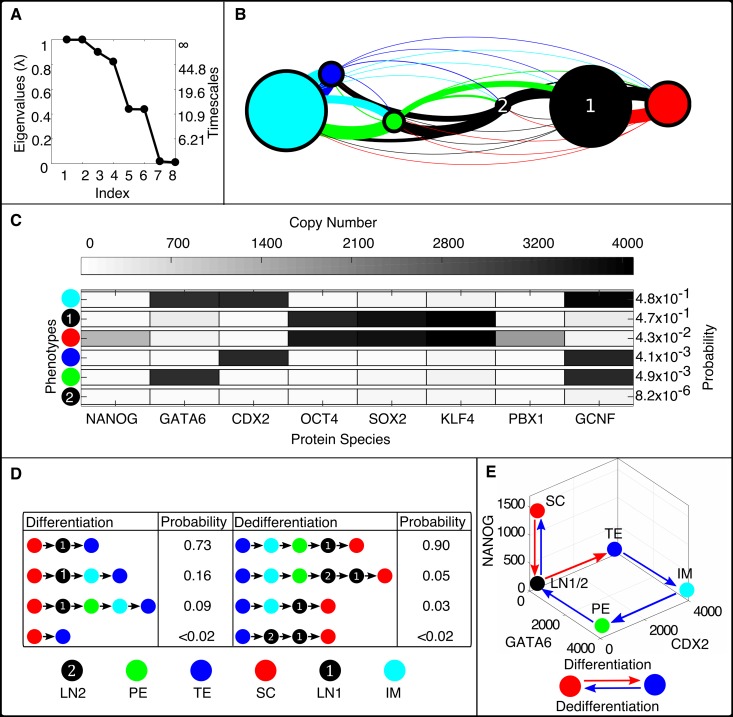
Simulation results for the pluripotency network (Parameter Set I).The Computational Pipeline Uncovers Six Metastable Phenotypes and Irreversible Phenotype Transitions. A) Computed eigenvalue spectrum and global timescales indicating the presence of metastability in the network. The gap in the eigenvalue spectrum after the sixth eigenvalue suggests that a partitioning can be found into six metastable phenotypes. B) The coarse-grained network showing six algorithmically-identified phenotypes designated as Low NANOG 1 (LN1), Low NANOG 2 (LN2), Stem Cell (SC), Primitive Endoderm (PE), Trophectoderm (TE), and the Intermediate Cell (IM) state. C) The averaged gene expression levels (copy numbers) of each transcription factor for each phenotype and their respective steady-state probabilities. D) The four most probable transition pathways from the SC state to the TE state (differentiation) and from the TE state to the SC state (dedifferentiation). E) The highest probability transition paths projected onto three protein coordinates, NANOG, GATA6, and CDX2. Differentiation from SC to TE is visibly irreversible, i.e., the system returns by a separate route.